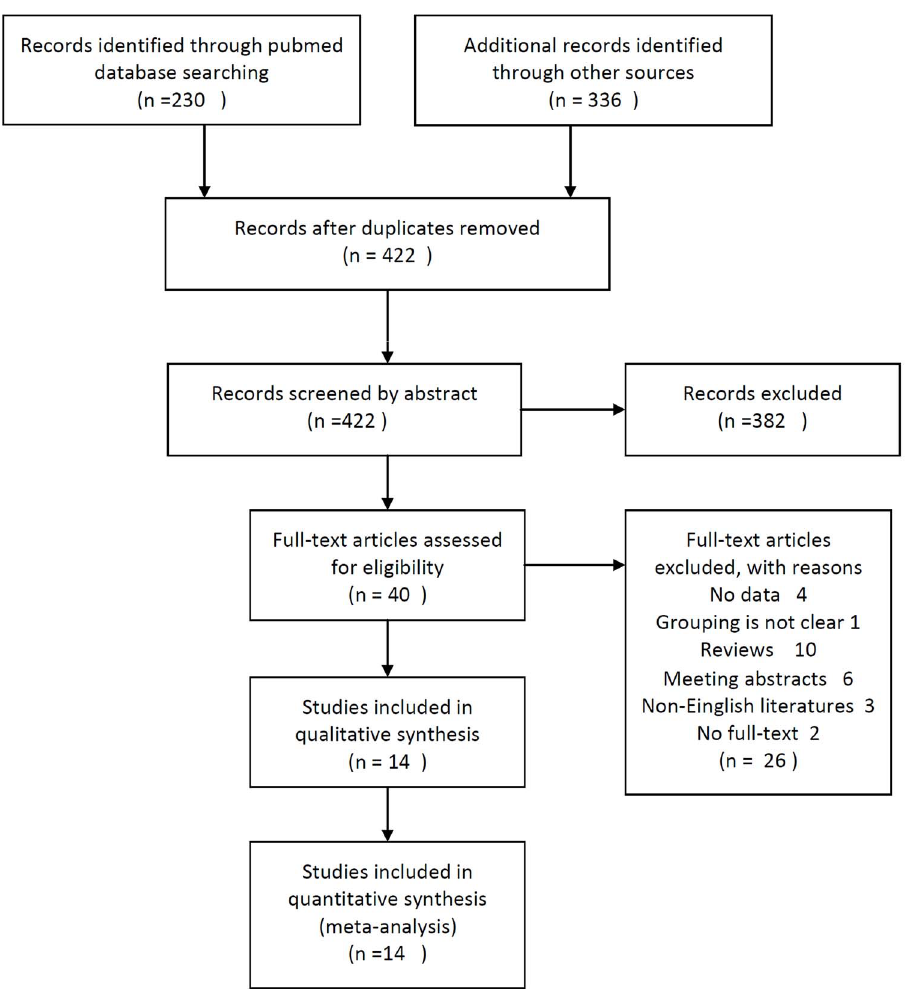
Figure 1. Flow chart of the eligible studies. Flow chart of the eligible studies for the meta-analysis of c-Met overexpression and prognosis of gastric cancer, with specifications of reasons.